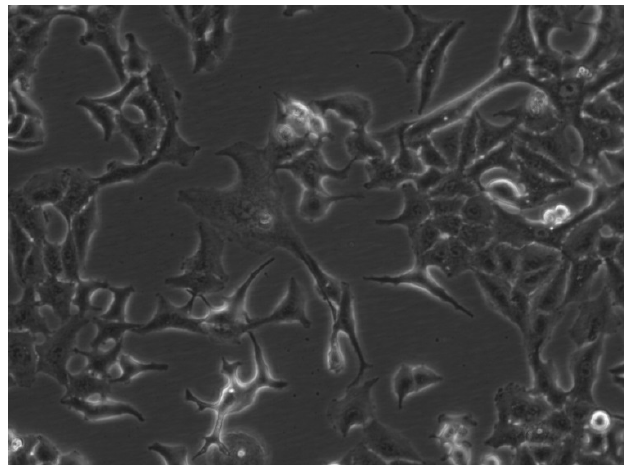
Figure 1. A549 cells captured at the American University of Beirut (AUB Lab).